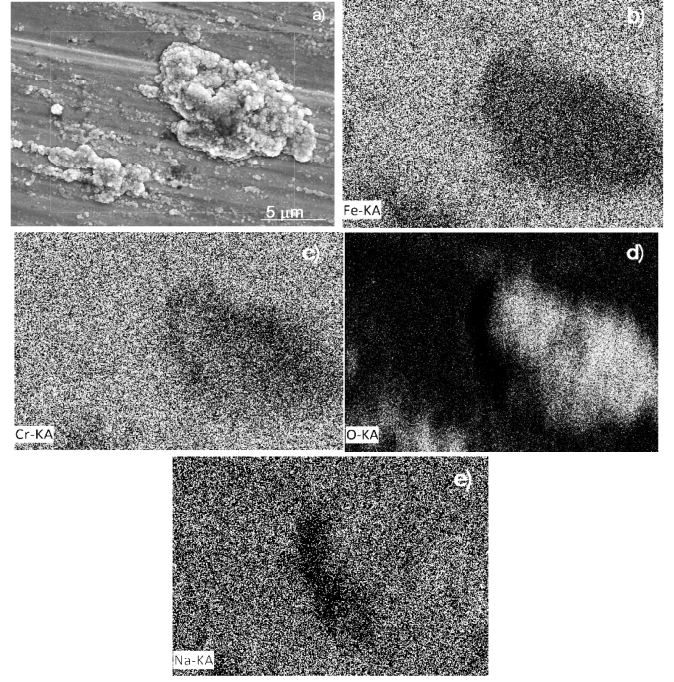
Figure 9. SEM micrograph of T91 steel corroded in 60 wt% NaNO 3 -40KNO 3 at 400 °C showing ( a ) secondary electrons image and EDX mappings of ( b ) Fe, ( c ) Cr, ( d ) O and ( e ) Na.